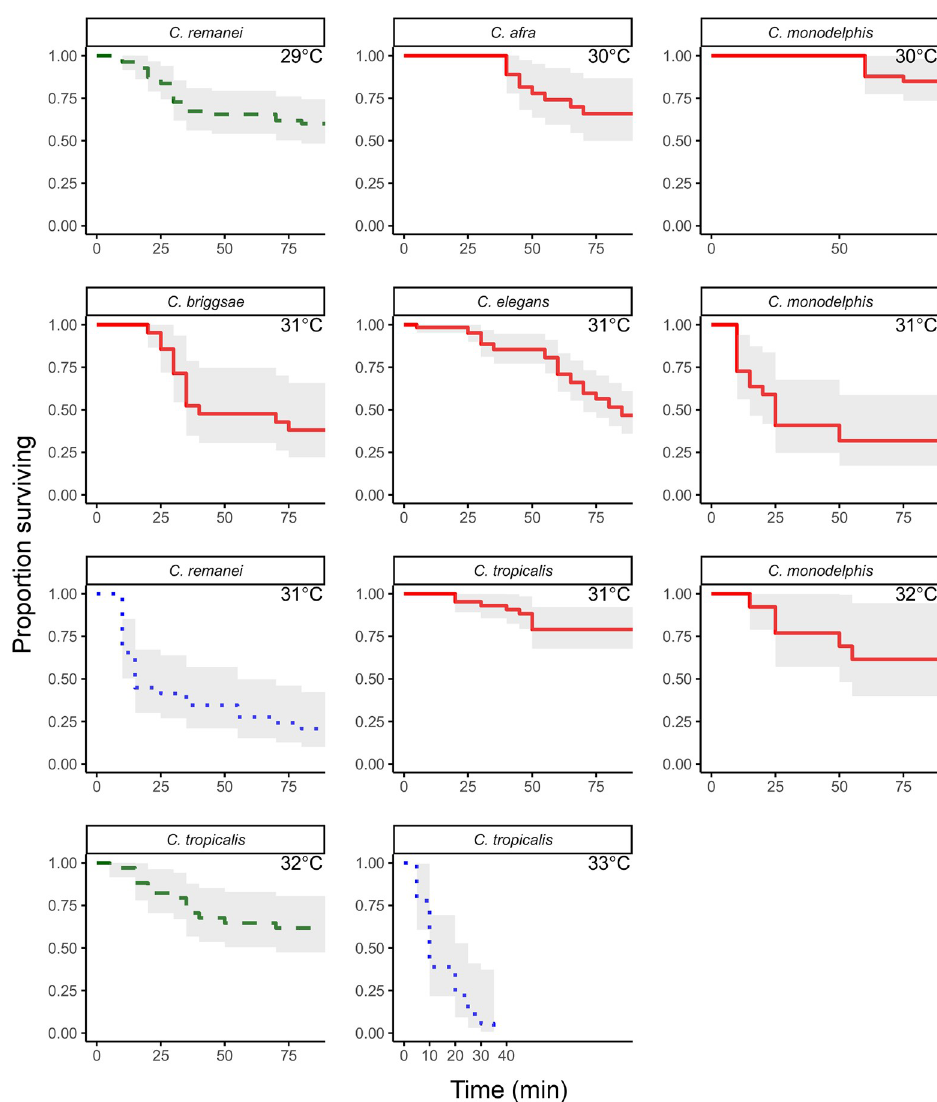
Fig 4. Survivorship curves for Caenorhabditis species. Despite extreme conservation in morphological development, Caenorhabditis species demonstrate distinct differences in ability to survive heat stress. For example, nearly 50% of embryos from the temperate species C . remanei die within 90min when reared at 29˚C, but embryos of the tropical species C . tropicalis must be exposed to 32˚C to exhibit the same survivorship pattern (green dashed lines). However, at just one degree higher, 33˚C, C . tropicalis embryos show severe and rapid lethality, while a two degree increase for C . remanei , to 31˚C, does not induce as dramatic an increase in lethality (blue dotted lines), suggesting a potential biophysical ceiling for adaptation to high heat.